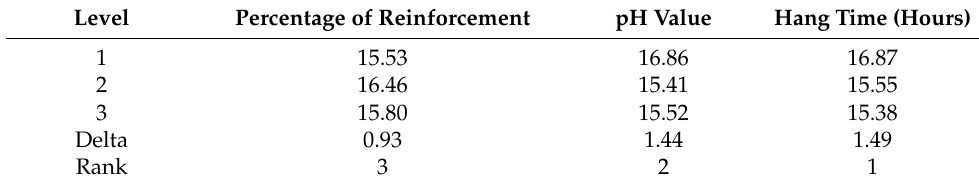
Table 16. Response table for signal to noise ratios (smaller is better).